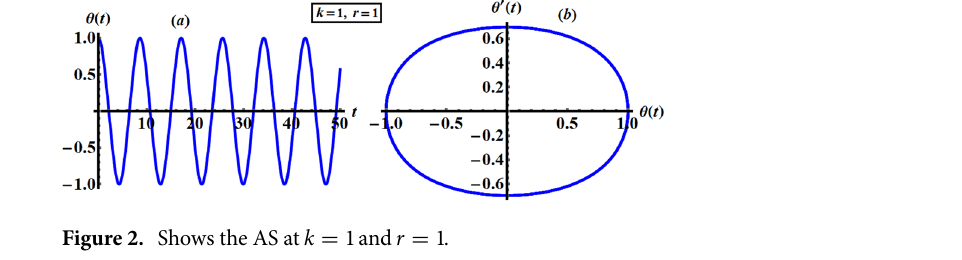
Figure 2. Shows the AS at k = 1 and r = 1 .